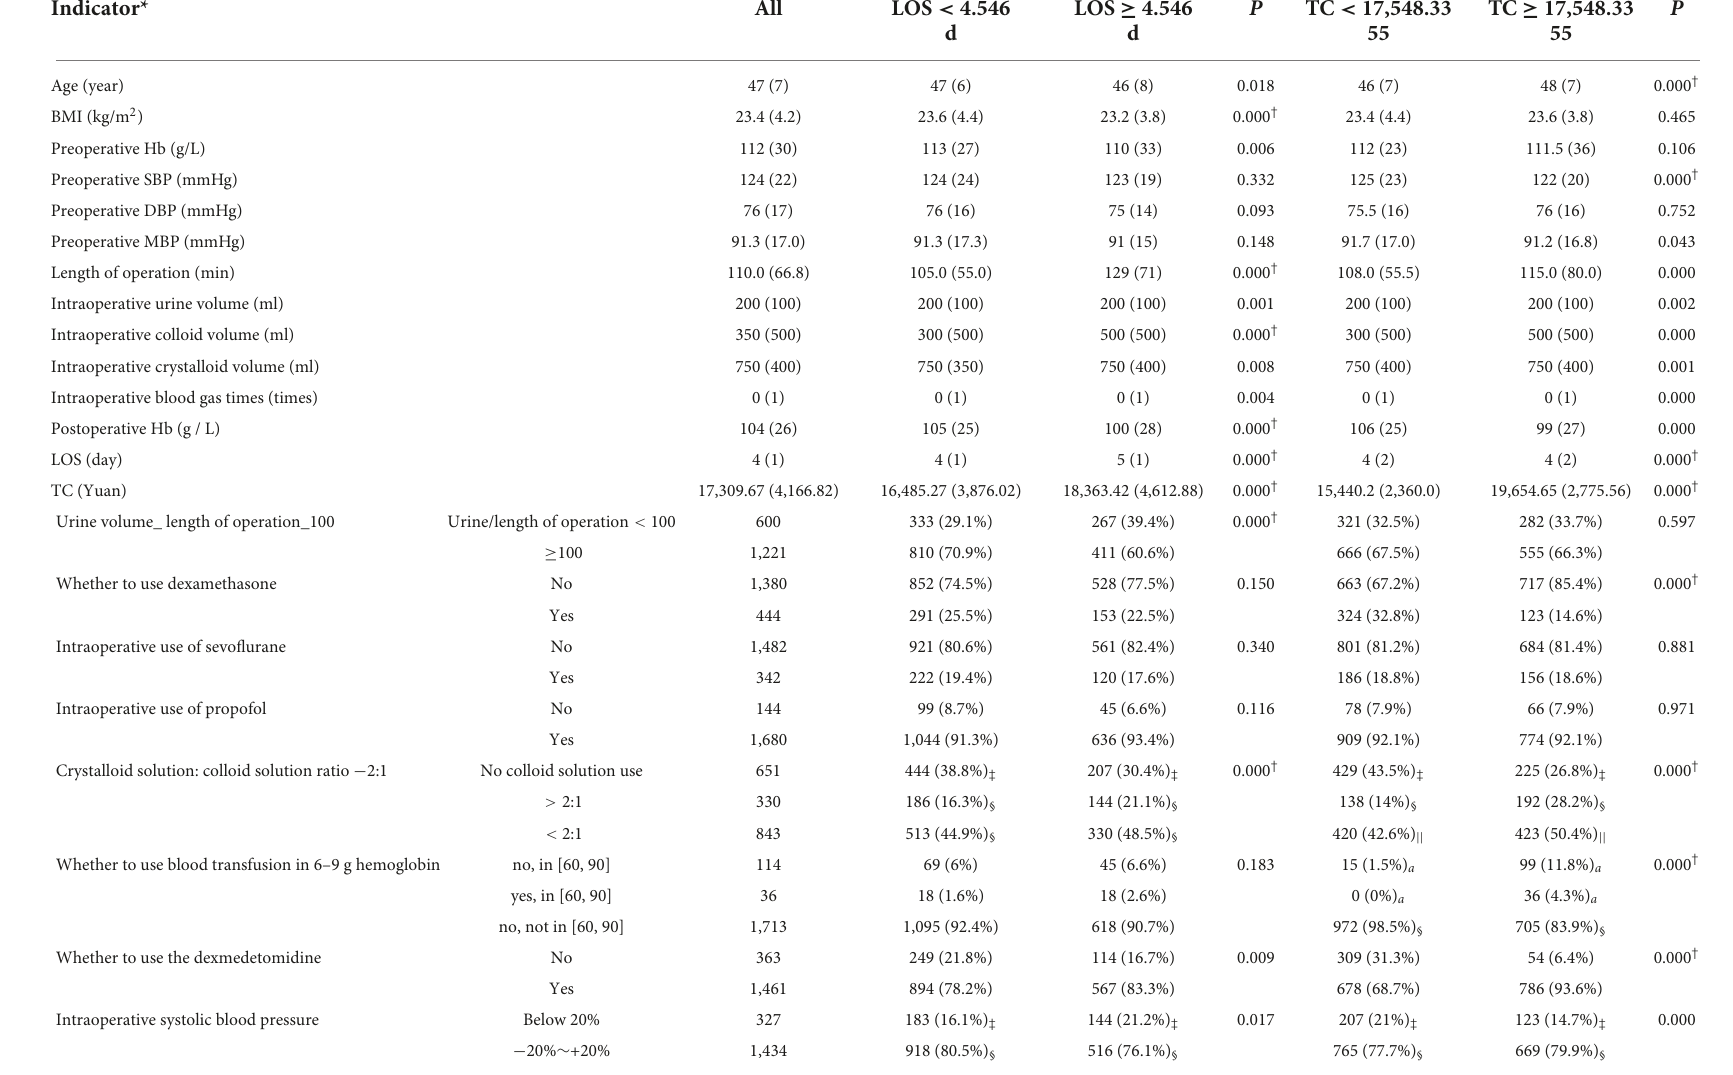
TABLE 2 The comparisons of the general conditions of patients and the indicators associated with anesthetic